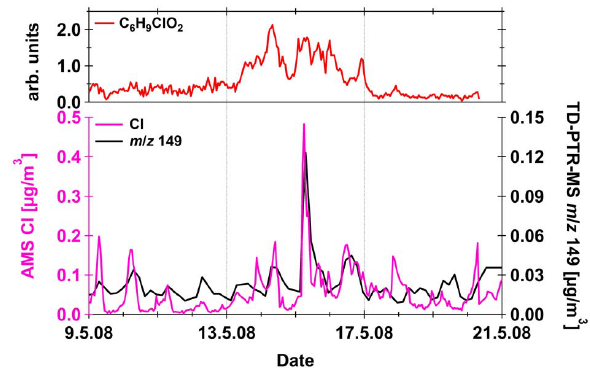
Fig. 7. Comparison of AMS to TD-PTR-MS results. Lower panel: Figure 7: Comparison of AMS to TD-PTR-MS results. Lower panel: AMS chloride (purple, 3 AMS chloride (purple, left axis) and TD-PTR-MS mass trace at left axis) and TD-PTR-MS mass trace at m / z 149 (black, right axis). Upper panel: AMS high 4 m/z 149 (black, right axis). Upper panel: AMS high resolution traces resolution traces of C 6 H 9 ClO 2 ( m / z 148.029, red). 5 of C 6 H 9 ClO 2 ( m/z 148.029, red).